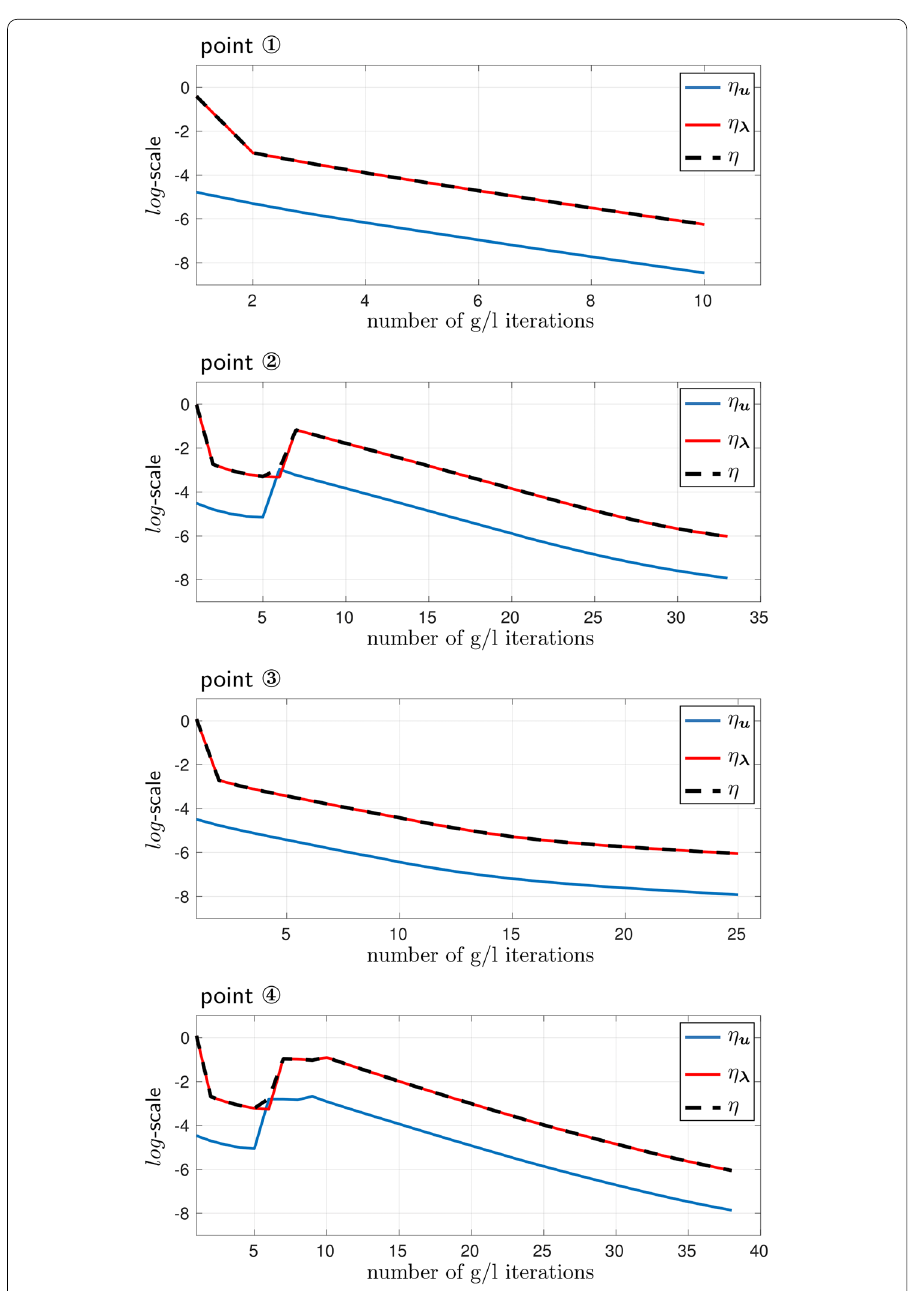
Fig. 9 Convergence behavior of the global/local iterative solution process at four different loading steps (the points 1–4 from Fig. 5c), illustrated in terms of the indicator η , as well as its ingredients η u and η λ